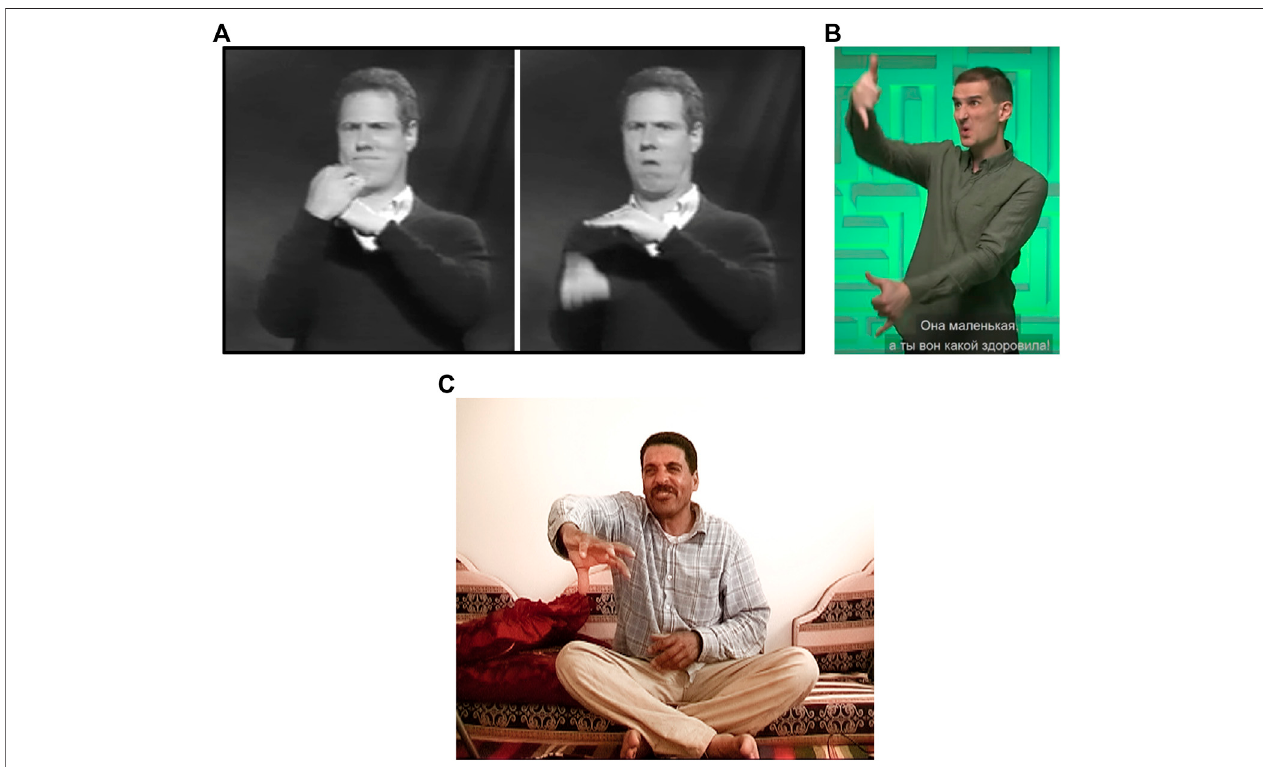
FIGURE11|(A) ASLopeningmouthgestureforadrawbridgeopening(BenBahan ’ stellingofHansChristianAndersen ’ s “ TheLittleMermaid ” ). (B) Suckedcheeks Russian Sign Language mouth gesture for “ very tall ” (Chekhov ’ s online story “ Chameleon ” in RSL). (C) Teeth-lip friction in Al-Sayyid Bedouin Sign Language mouth gesture for water spraying from a tap (retelling Laurel & Hardy ’ s silent movie, “ Big Business ” ).